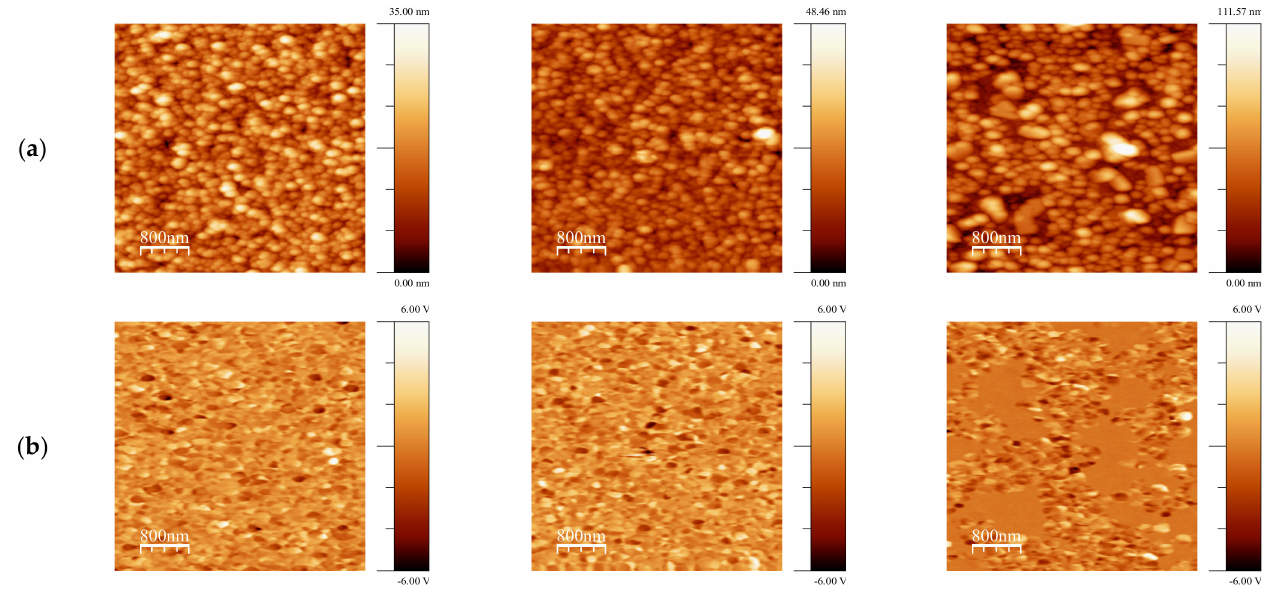
Figure 3. ( a ) Topography, ( b ) out-of-plane (OPP) Piezoresponse Force Microscopy of BiFeO 3 sol–gel films annealed at at 550 ◦ C ( left column ), 600 ◦ C ( middle column ) and 700 ◦ C ( right column ).